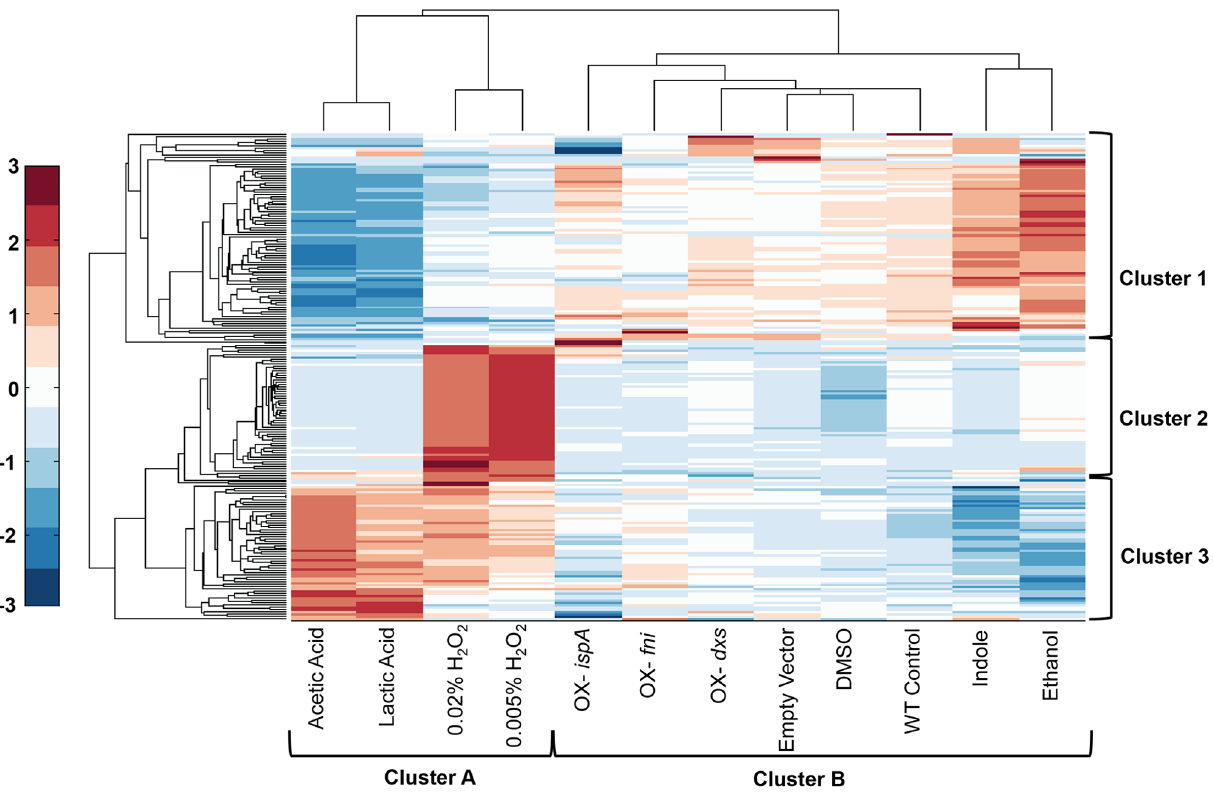
Figure 6. Clustering of the reduced transcriptome identifies similar expression patterns in acetic acid, lactic acid, and H 2 0 2 perturbations. Genes and conditions were clustered using squared Euclidean distance metric. The genes in each cluster are listed in Tables S2, S3, S4.